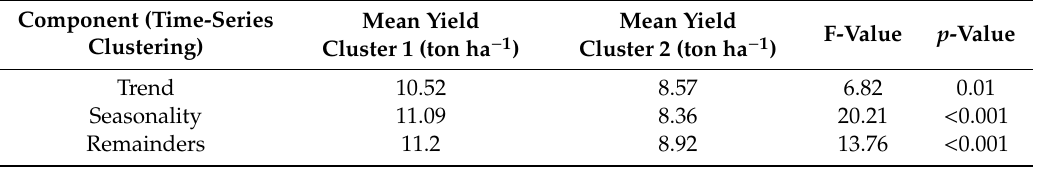
Table 4. Results for the ANOVA analysis determining the di ff erences between yield levels in the clusters of each time-series clustering map, based on 65 sample points. The yield data were derived by a weighing harvesting machine on 22 August